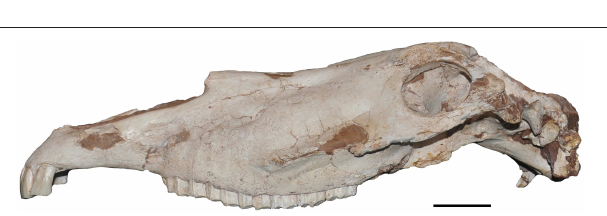
FIGURE 7 | Comparison of cheek tooth row length and basilar length in several extinct and extant species of Equidae.